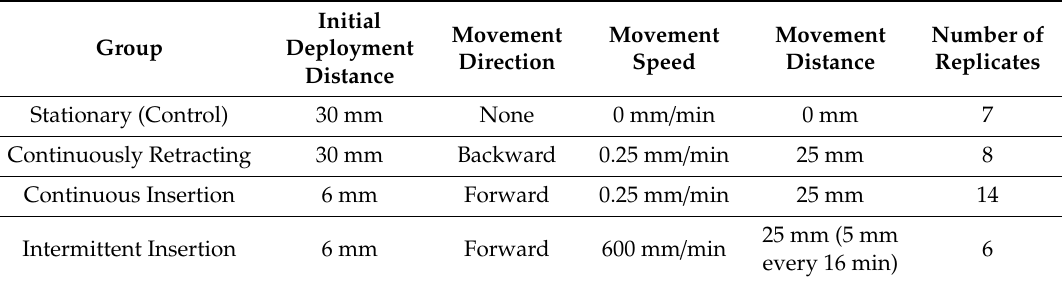
Table 1. Experimental group